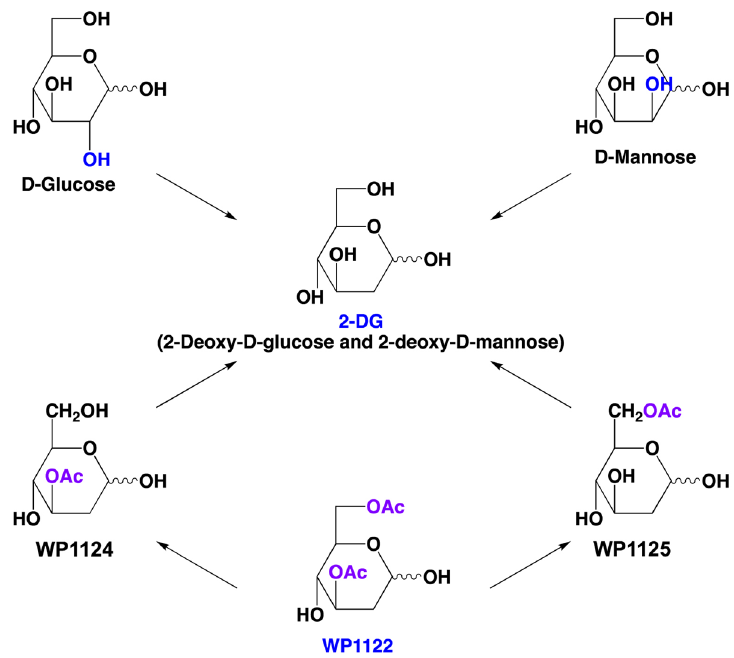
Figure 2. Structures of D-mannose, D-glucose, 2-DG (2-deoxy-D-glucose; 2-deoxy-D-mannose), and WP1122 (2-DG prodrug). Within the cell, WP1122 is deacetylated by cellular esterases to monoacetates: WP1124 and WP1125, and subsequently release active 2-DG.